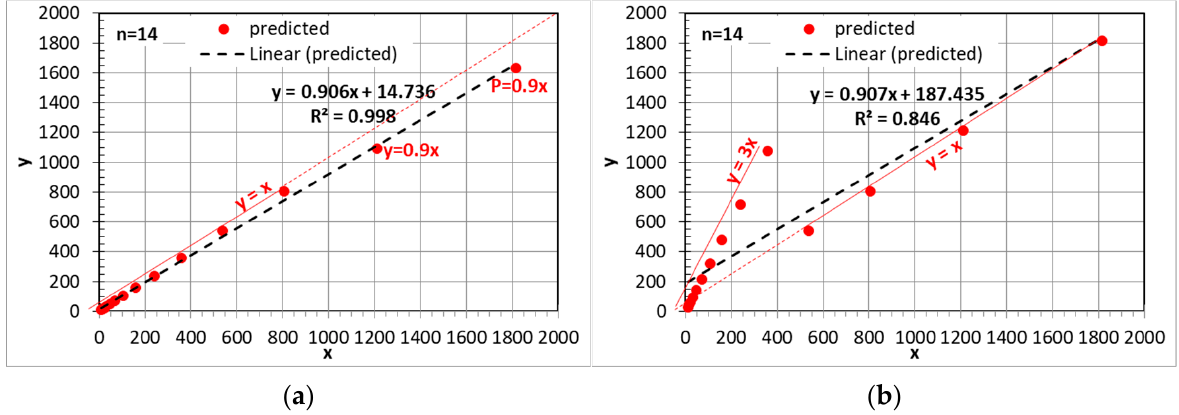
Figure 1. Example of two series with the same linear regression slope and good coefficients of determination, but with very different behaviours.